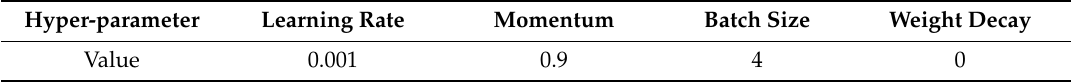
Table 4. Hyper-parameters obtained.